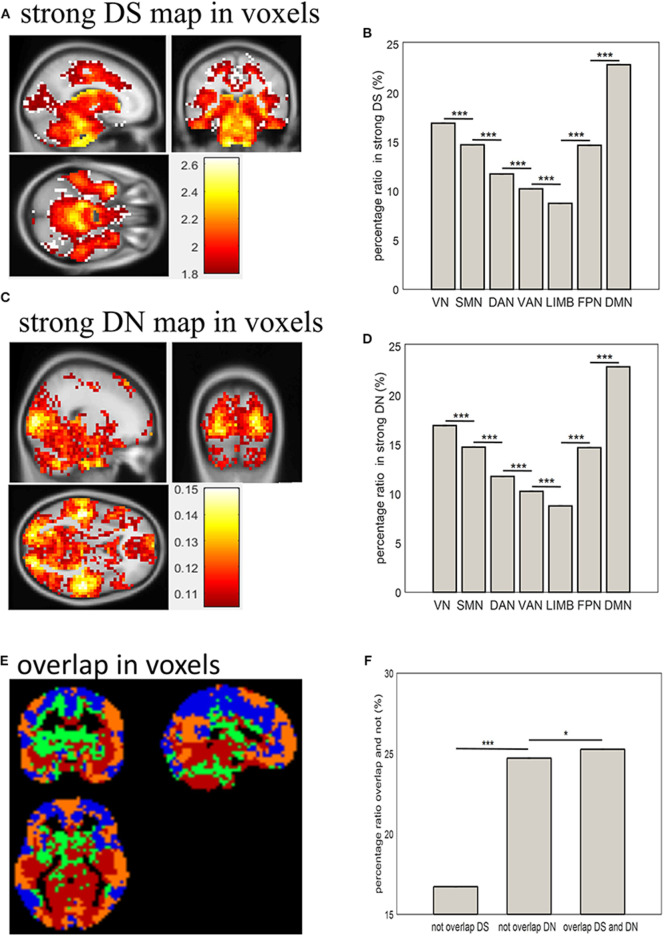
Distribution of strong DS and DN in terms of voxels and networks. (A,C) show spatial distribution of strong DS and DN in terms of voxels; (B,D) show bar plots of percentage ratios of voxels of DS and DN, respectively, for seven networks; (E) shows spatial distribution of overlapping strong DS and DN in terms of voxels: blue indicates brain regions with weak DS and DN (below 75%); green and yellow indicated unique brain regions with strong DS and DN (above 75%) respectively; red indicates brain regions with strong overlapping DS and DN (above 75%); (F) shows a bar plot of the percentage ratios of voxels overlapping and not overlapping between strong DS and DN. Two-sample t-tests showed significant differences between them (*p < 0.05, ***p < 0.001).